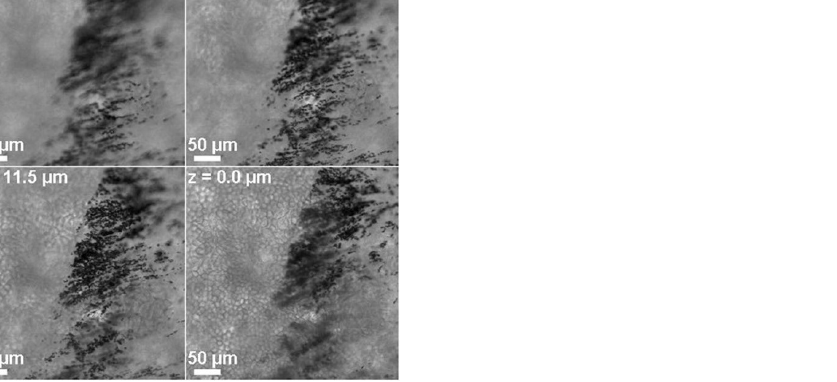
Figure 13. Horizontal cross sections of PVP-FeNp aggregate distribution in mucus. There is no magnetic force and gravity in the horizontal direction, only diffusion effects exist. z = 0 represents the bottom of mucus layer. Images were taken one hour after releasing MNPs. This figure is taken directly from Ref. [17]. Reproduced with permission from Economou, E.C, BioNanoScience; published by Springer Nature, 2016.